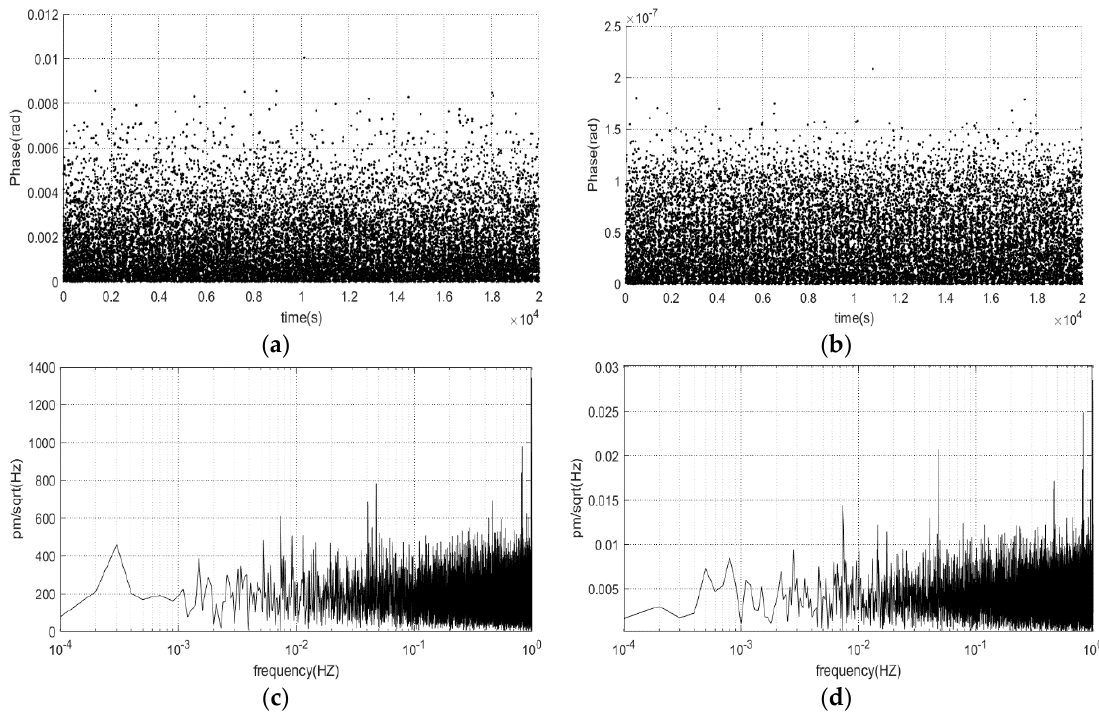
Figure 7. Phase noise due to random aberrations of population size λ/30 and its corresponding PSD. ( a ) is the phase noise signals with RSA, and ( b ) is the phase noise signals without RSA. The corresponding PSD of ( a ) is ( c ), ( b ) is ( d ).